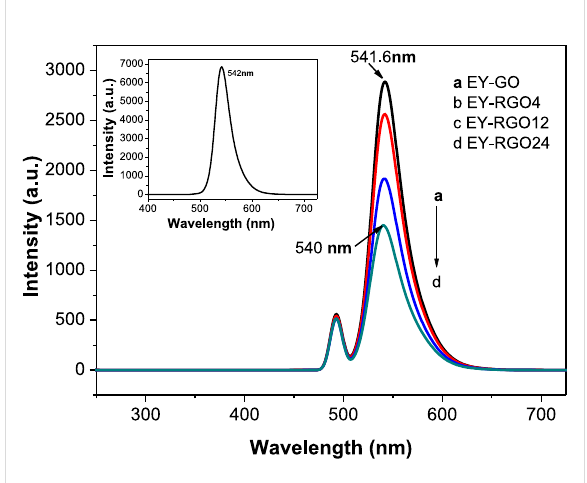
Figure 4: Fluorescence spectra of EY-RGO x in TMA solution. The inset shows the fluorescence spectrum of EY in TMA solution. Condi- tions: 30 μ g mL − 1 GO or RGO x ; 1.0 × 10 − 5 mol L − 1 EY; 7.7 × 10 − 2 mol L − 1